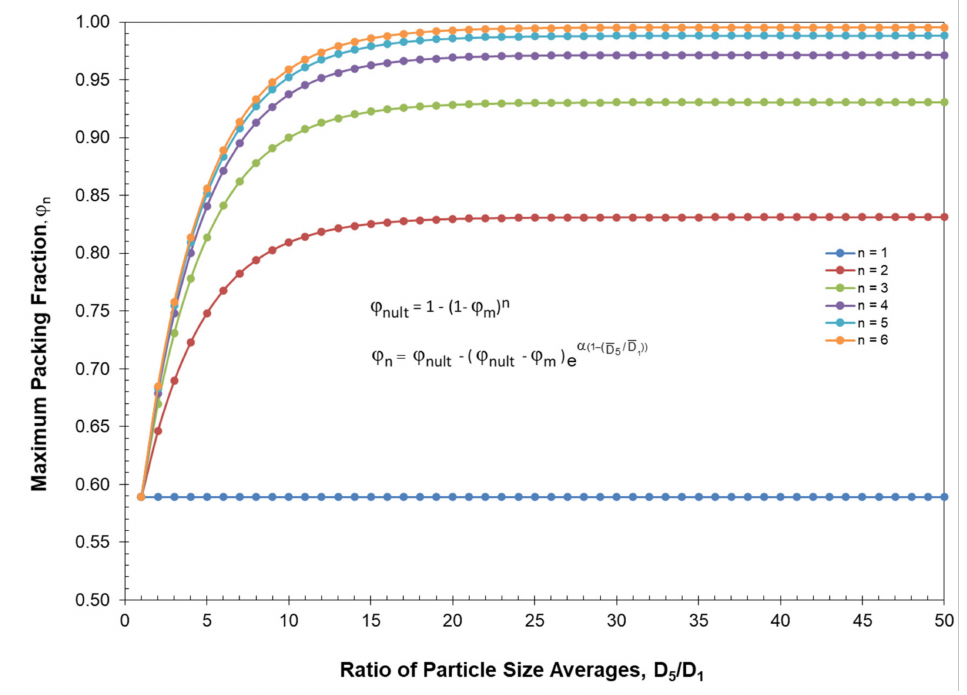
Figure 10. Theoretical maximum packing fraction vs. D5/D1.